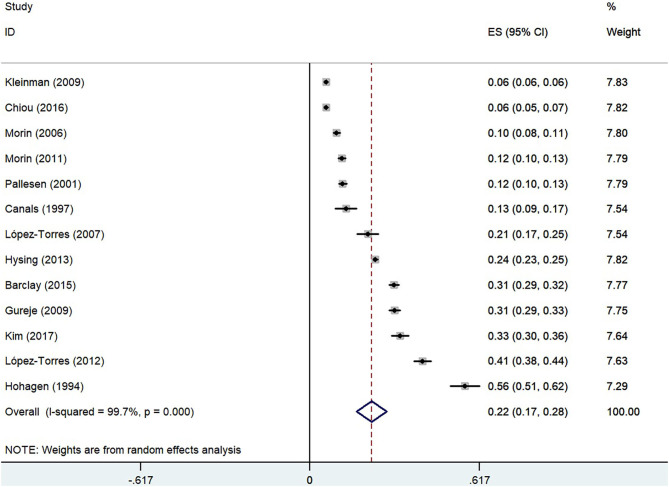
Forest plot of the prevalence of insomnia in the general population.